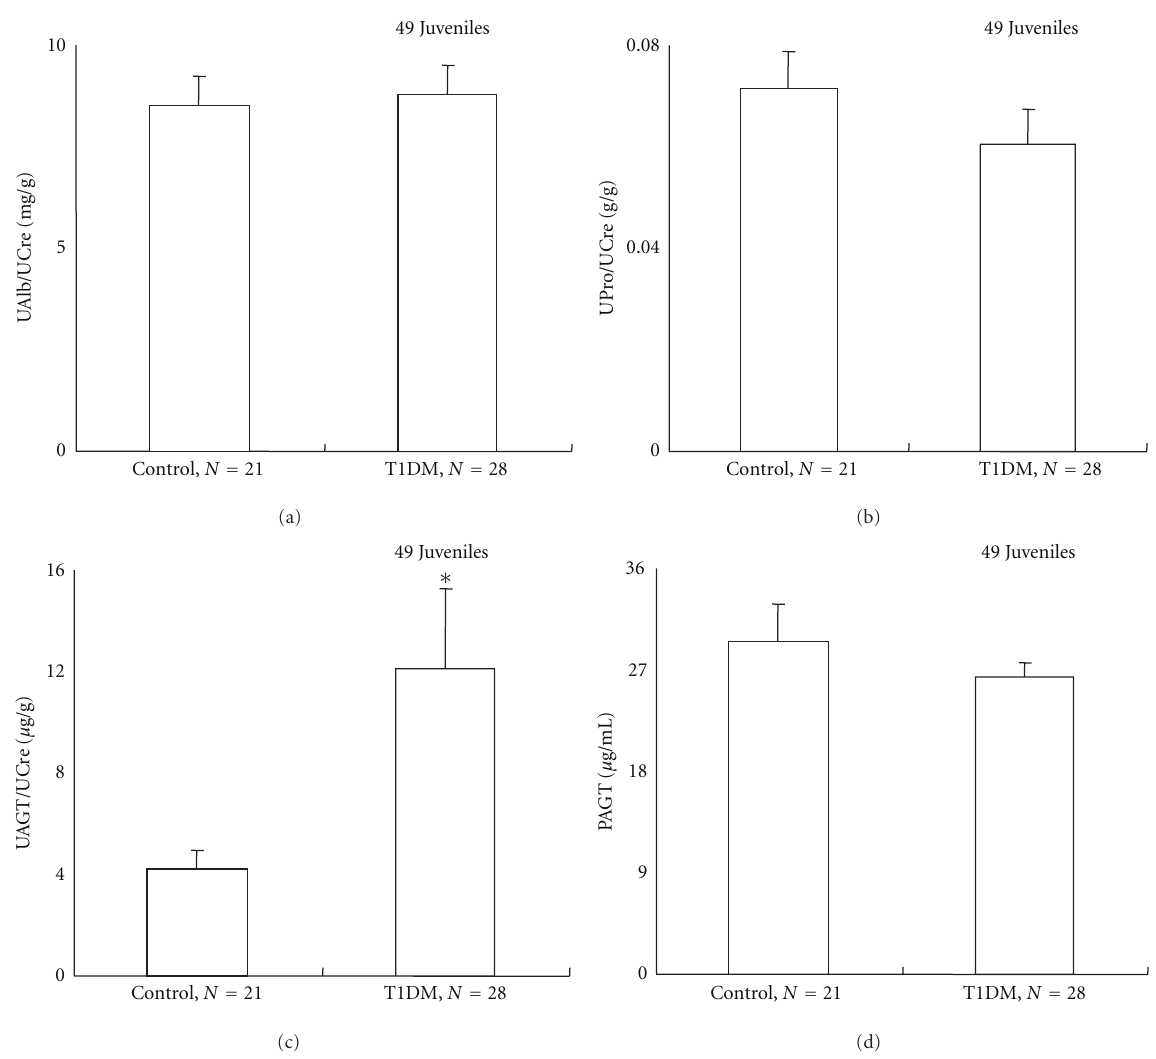
Figure 3: Urinary albumin-creatinine ratio (a) and urinary protein-creatinine ratio (b) were not increased in patients with type 1 diabetes (T1DM) compared to control subjects, suggesting that these patients were in the pre-microalbuminuric phase of diabetic nephropathy. However, urinary AGT-creatinine ratio was significantly increased in these patients compared to control subjects (c). Importantly, the AGT increase was not observed in plasma (d). Cited from Am J Med Sci 2009; 338: 478–480 by Saito et al.